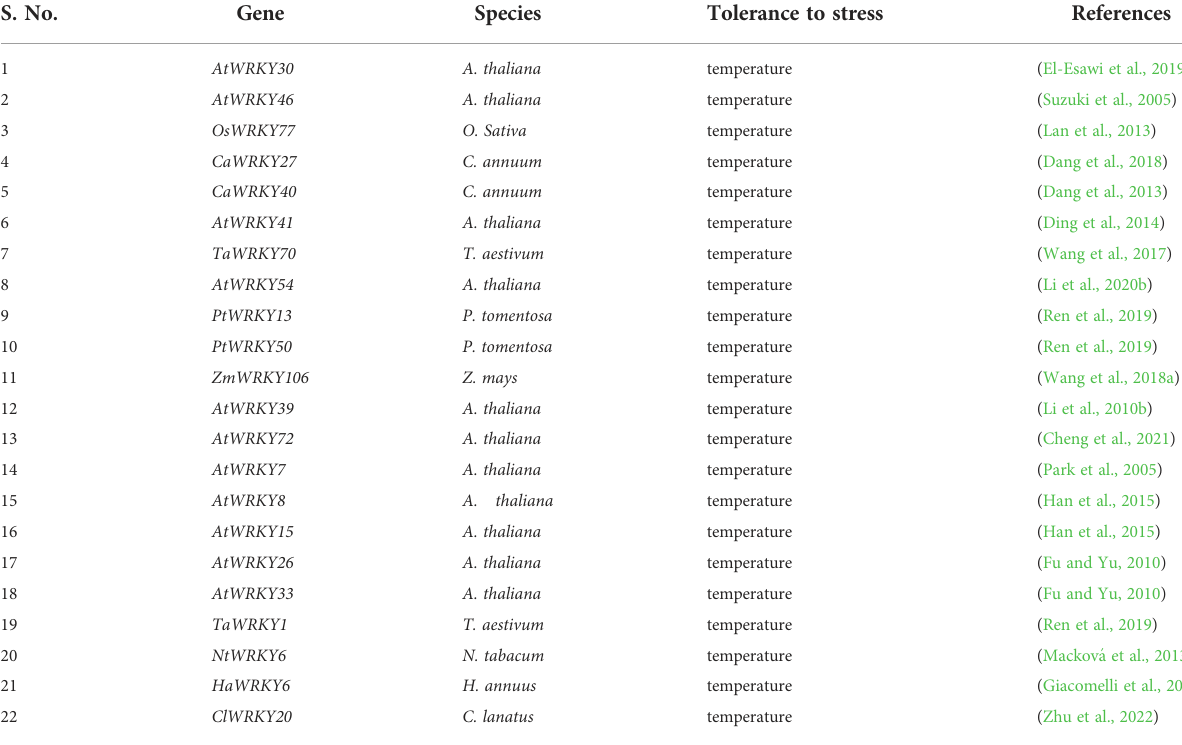
TABLE 3 Temperature stress-related WRKY TFs. S. No.